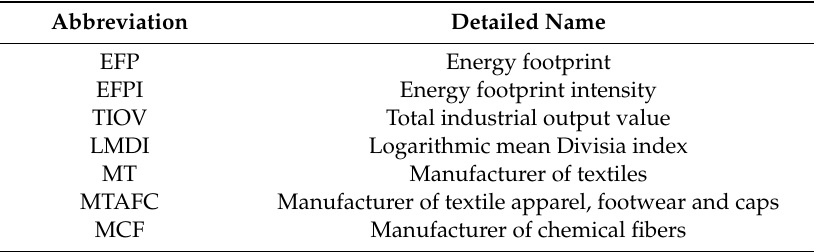
Table A1. Nomenclature comparison